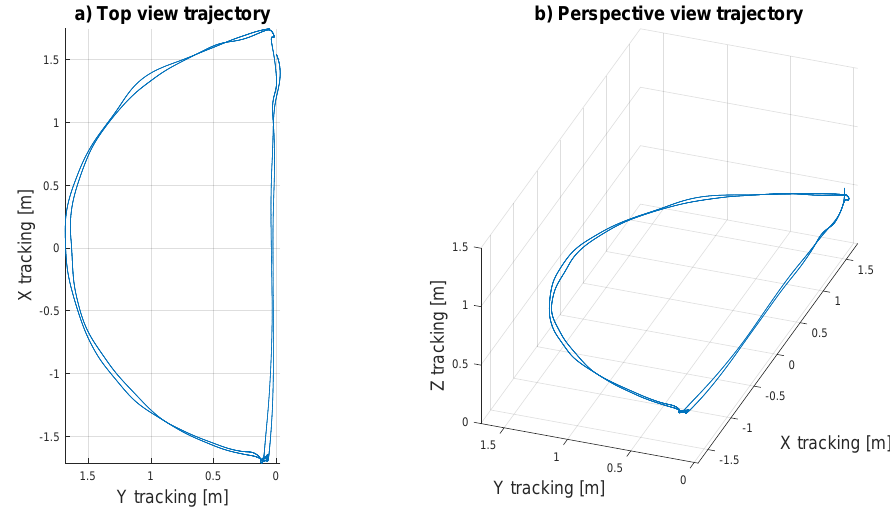
Figure 7. MAV trajectory: ( a ) top view; ( b ) perspective view. The two laps were performed at a flight height of 0.4